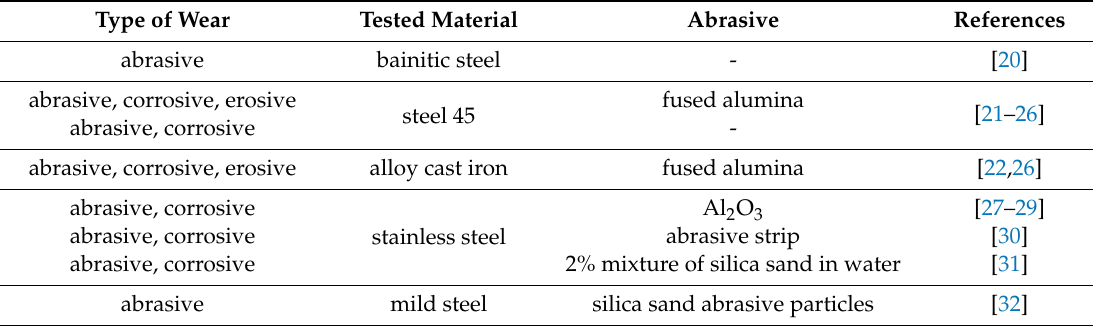
Table 1. Selected works in the field of steel wear